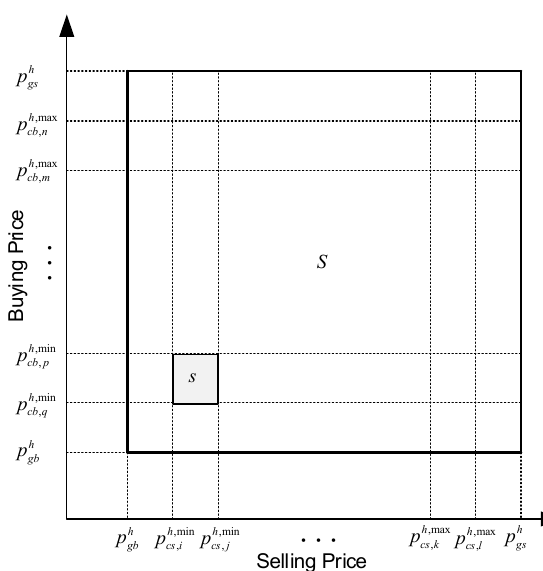
Figure 3. Feasible region of internal prices.